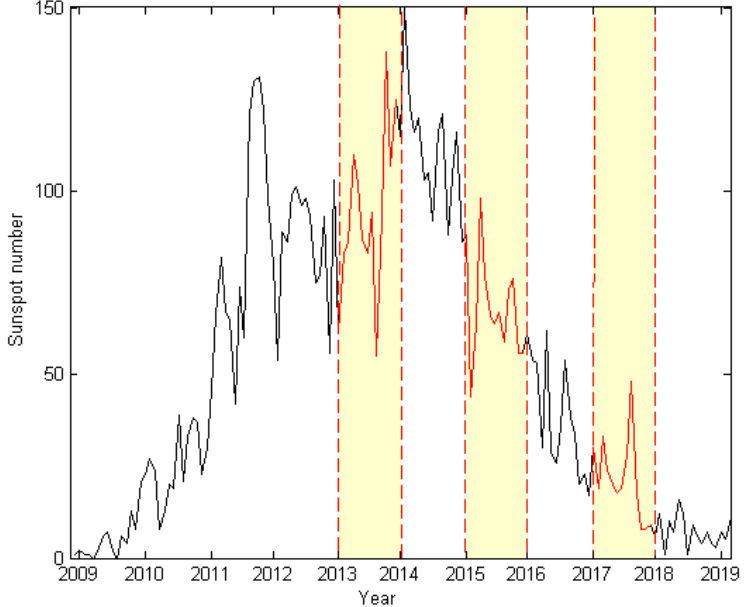
Figure 2. The sunspot number (monthly averaged) in the 24th solar cycle. The highlighted areas show three selected time intervals (years 2013, 2015, and